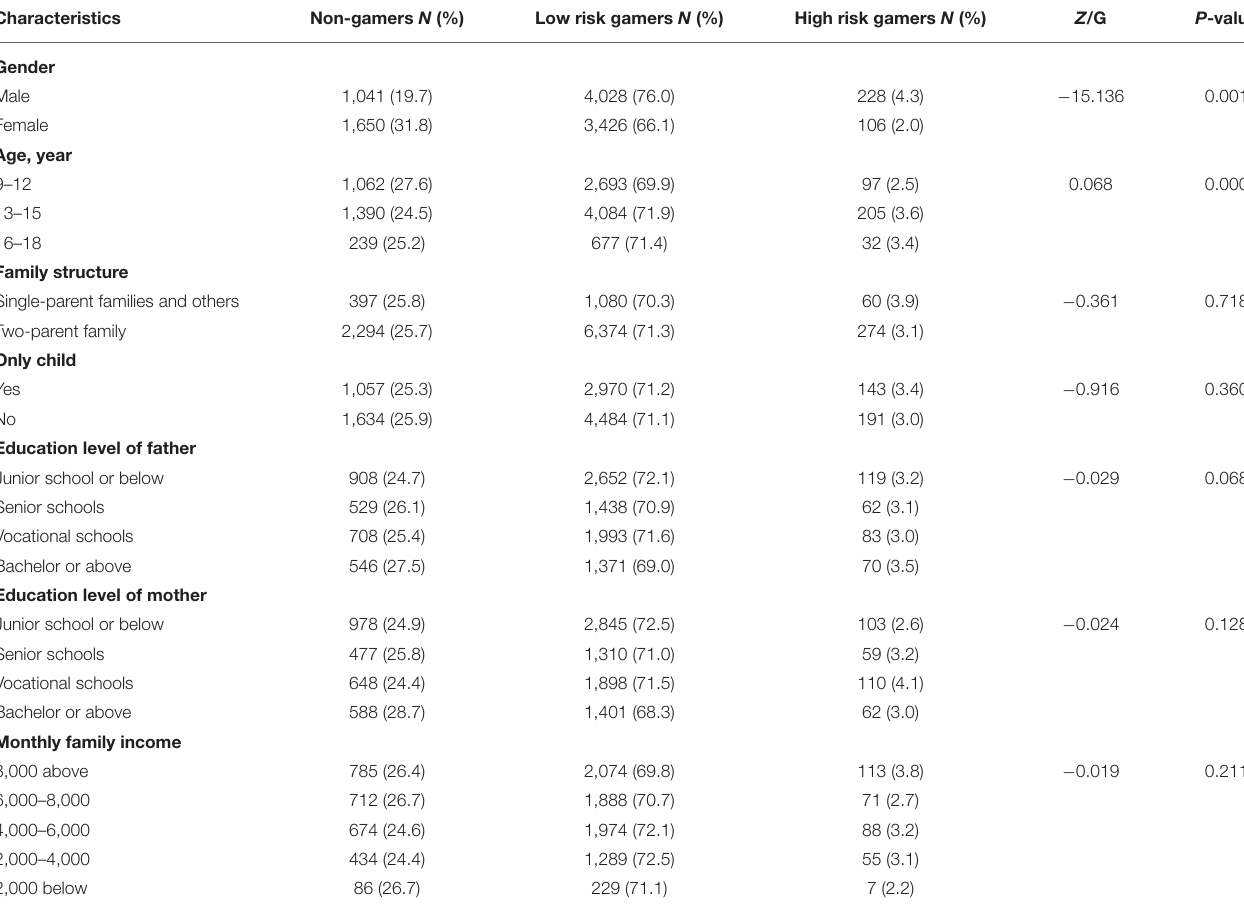
TABLE 2 | Estimated IGD prevalence in different participant demographic